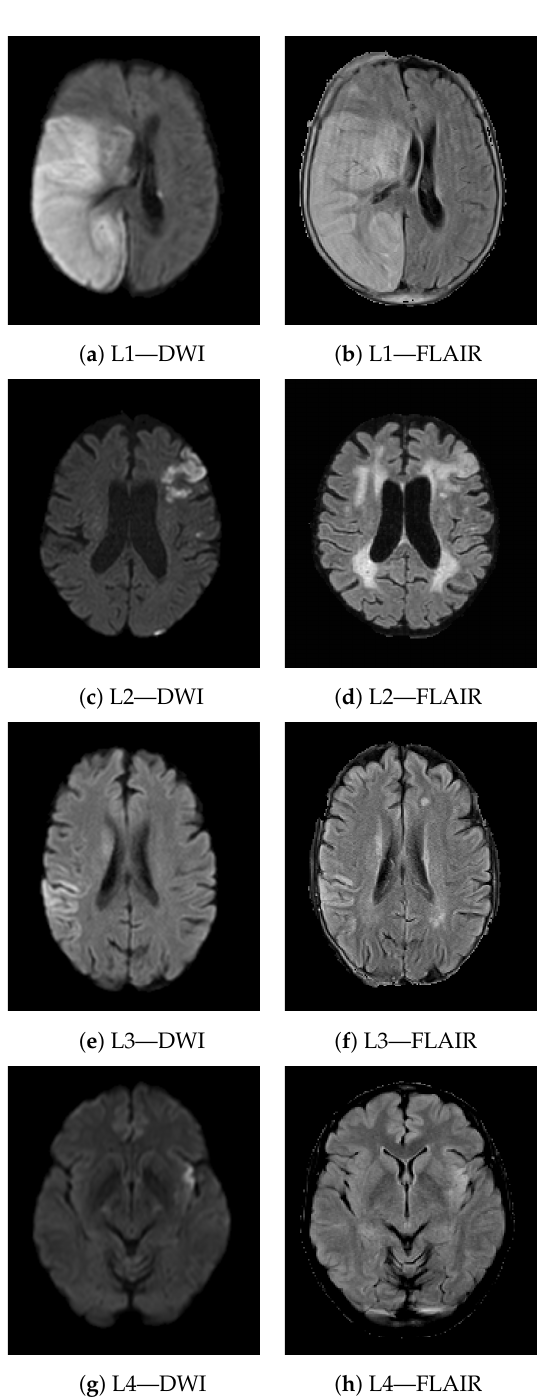
Figure 8. Axial views of DWI and T2-FLAIR scans from four different lesions (L1–L4). The lesions look hyperintense on both imaging sequences. L1 and L2 are two examples of patients with poor long-term functional outcome (90-day mRS of 6 and 5 respectively). L1 is quite extensive and presents PH1 hemorrage. Both lesions include WM and GM areas of the brain (texture heterogeneity measured in terms of Dependence non uniformity normalized—GLDM on DWI of 0.23 and 0.13, respectively). L3 and L4 instead are two examples of patients with good long-term functional outcome (90-day mRS of 2 and 0, respectively). Both lesions involve GM only (texture heterogeneity measured in terms of Dependence non uniformity normalized - GLDM on DWI of 0.08 and 0.04,